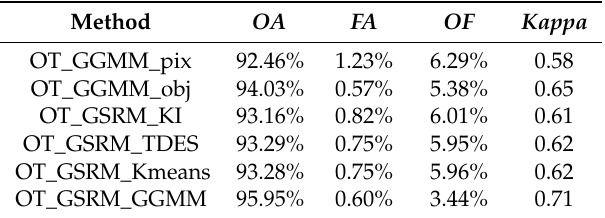
Table 5. Performance evaluation over LiangZi Lake between 2011 and 2016.